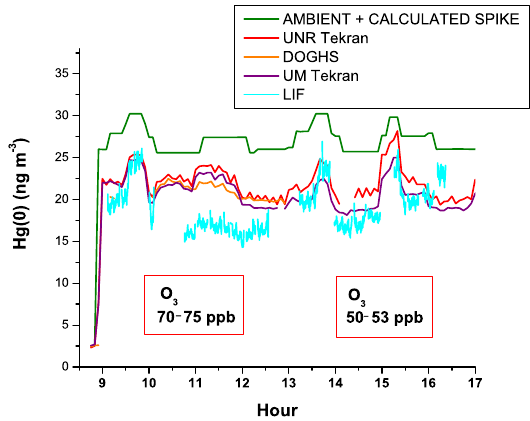
Figure 6. An ozone interference test on 7 September. A compari- son of the UM, UW and UNR Tekrans and the UM-2P-LIF mea- surements. The “expected” concentration calculated from the ambi- ent Hg(0) concentration prior to the spike plus the calculated spike concentration is also shown.